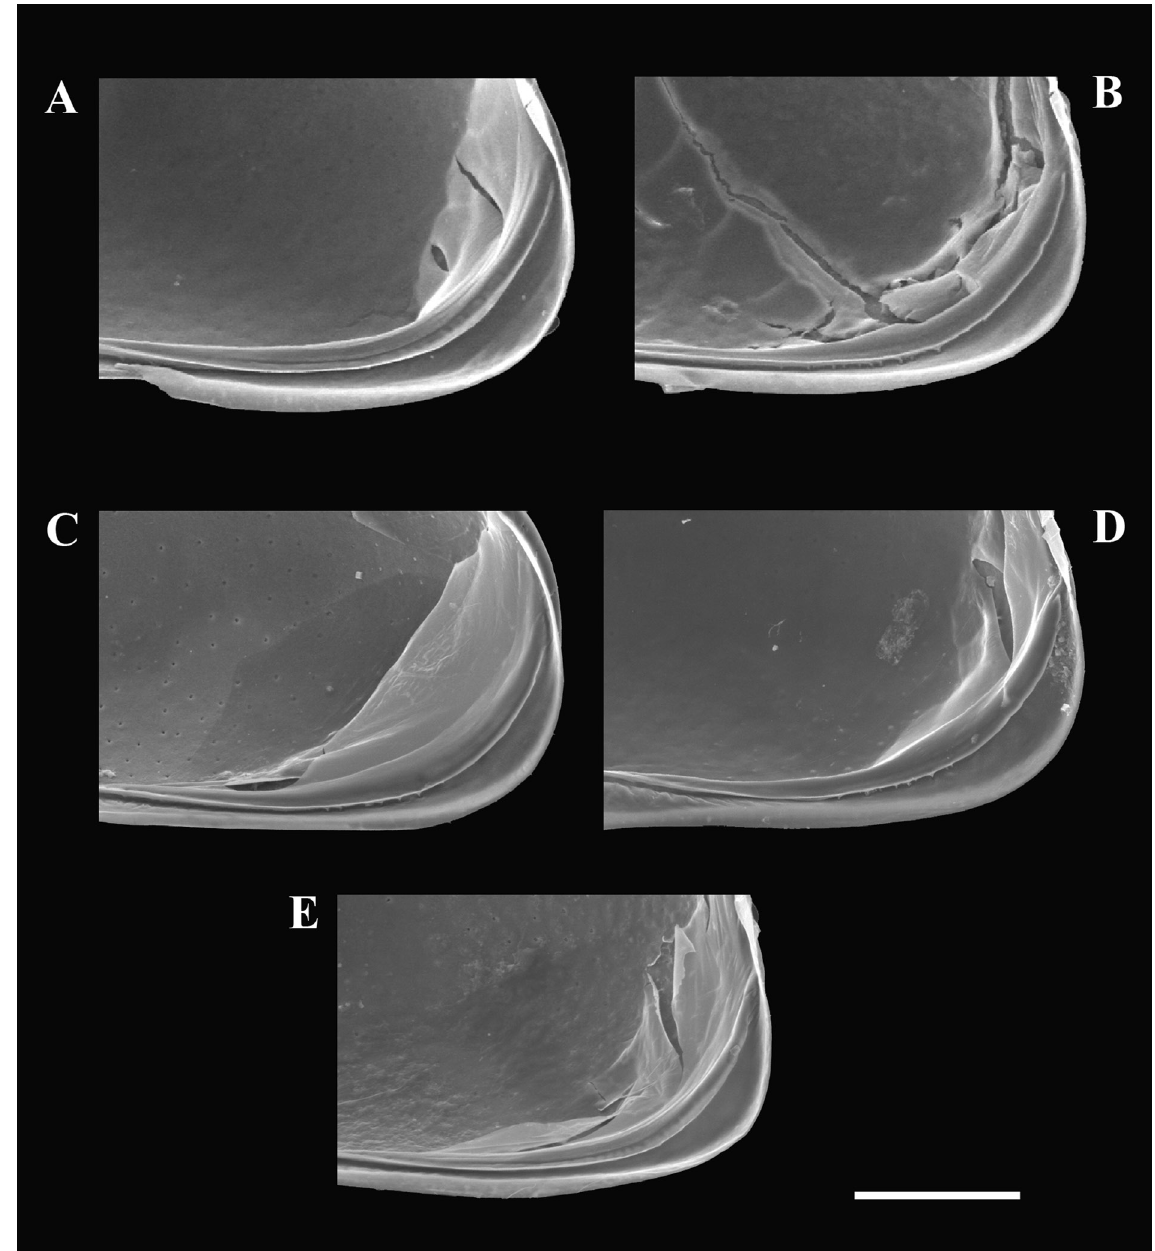
Fig. 19. Postero-ventral part of internal RV in Siamopsis spp., showing a smooth inner list and a few tiny tubercle-like structures beneath the inner list. A . S. renateae gen. et sp. nov. B . S. conspecta gen. et sp. nov. C . S. suttajit gen. et sp. nov. D . S. khoratensis gen. et sp. nov. E . S. planitia gen. et sp. nov. Scale bar: 100 μm. Arrows indicate tiny tubercle-like structures under postero-ventral inner